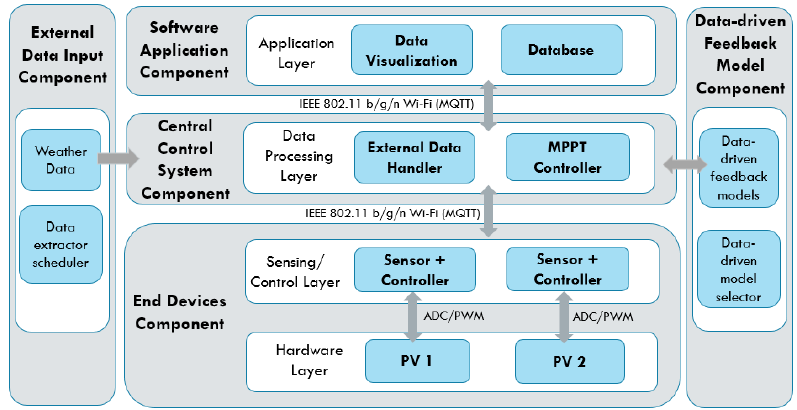
Figure 3. System architecture layer illustration (MPPT use case).